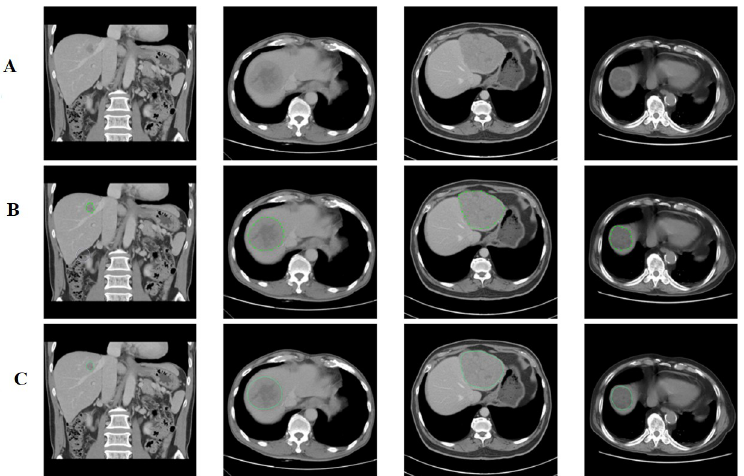
Fig 3. (A) Abnormal Hypodensities Without Labeling ROI. (B) Hypodensities with hand-marked ROIs. (C) Hypodensities with AI-predicted